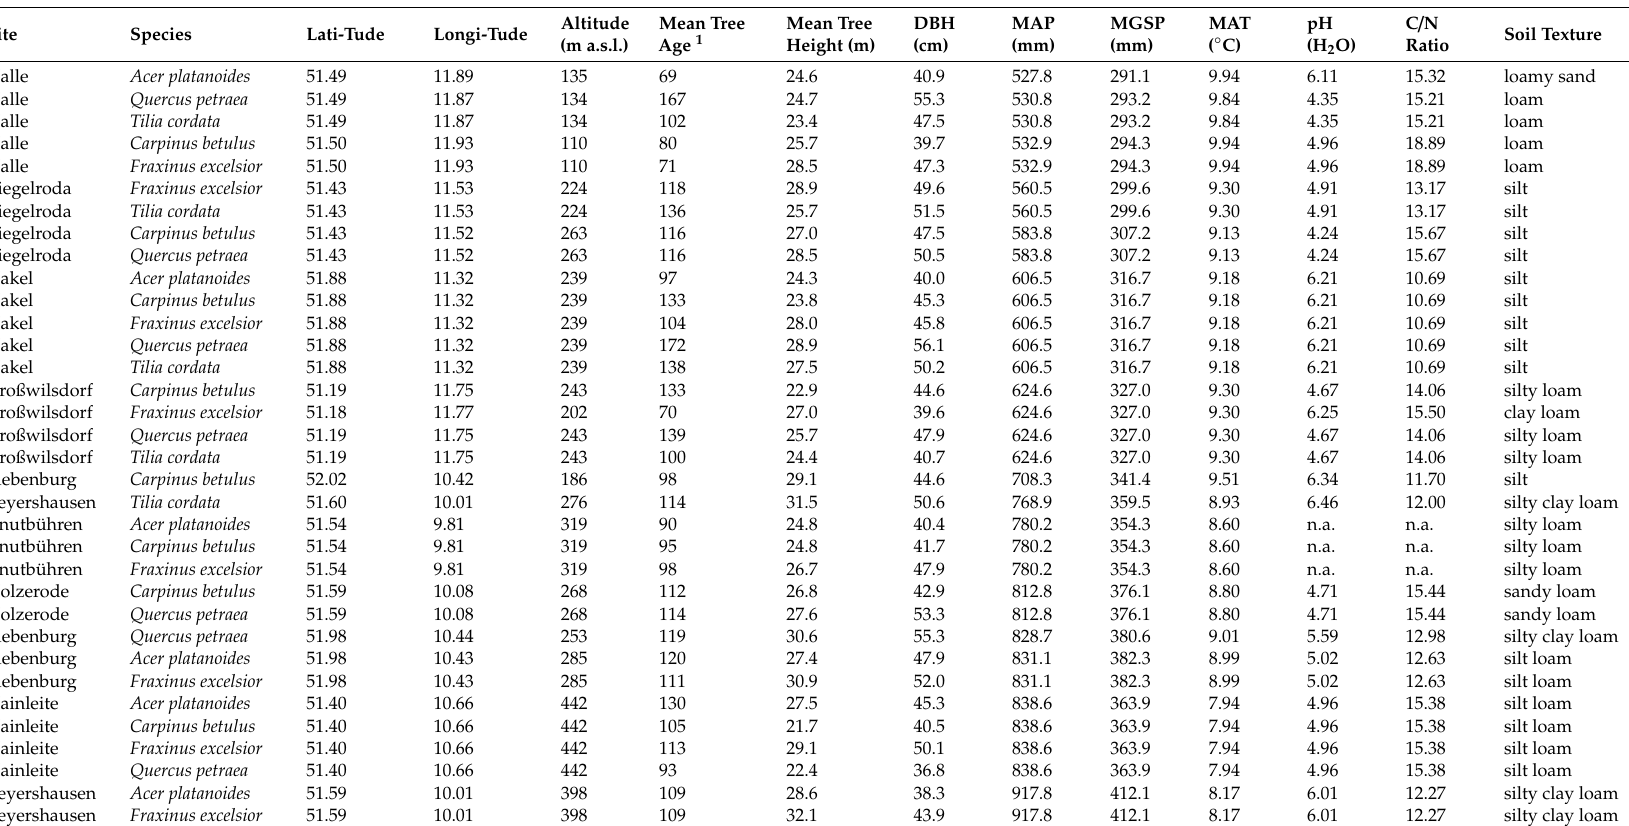
Table 1. Site and tree characteristics of the nine study sites with the each 2–5 species occurring in the stands, sorted in ascending order of mean annual precipitation